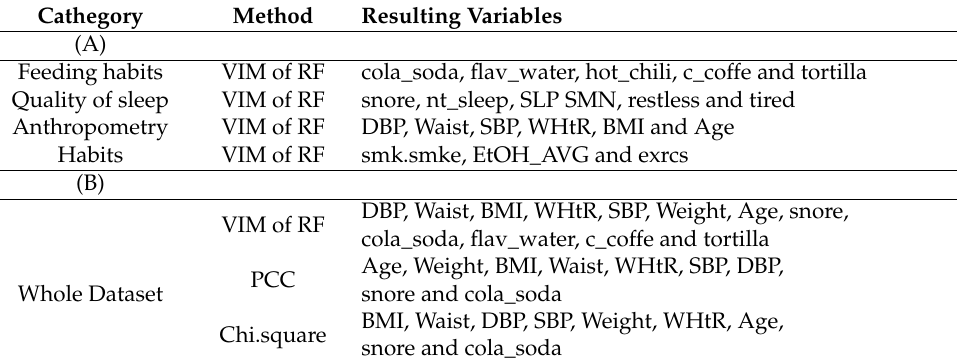
Table 2. (A) Most important variables in men by category. (B) Most important variables in men in whole